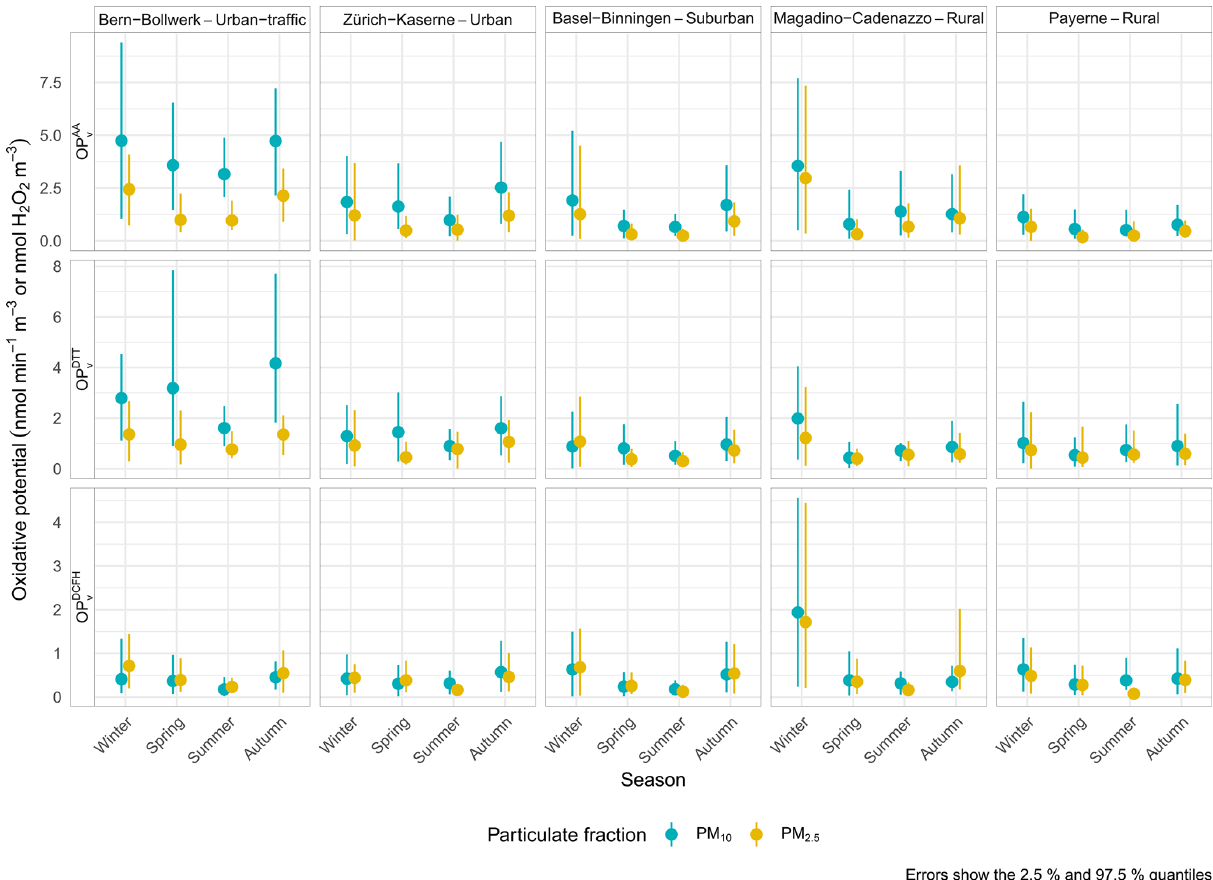
Figure 2. Seasonal means of three OP v assays, two PM size fractions, and five sampling sites in Switzerland between June 2018 and May 2019.